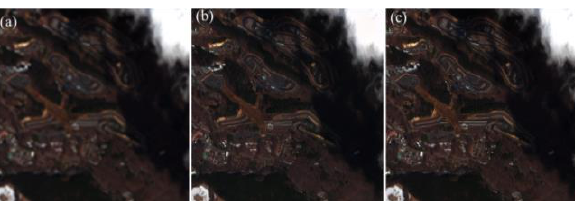
Figure 10 . Test results of EXP1 (a) LR image (2.0 m)